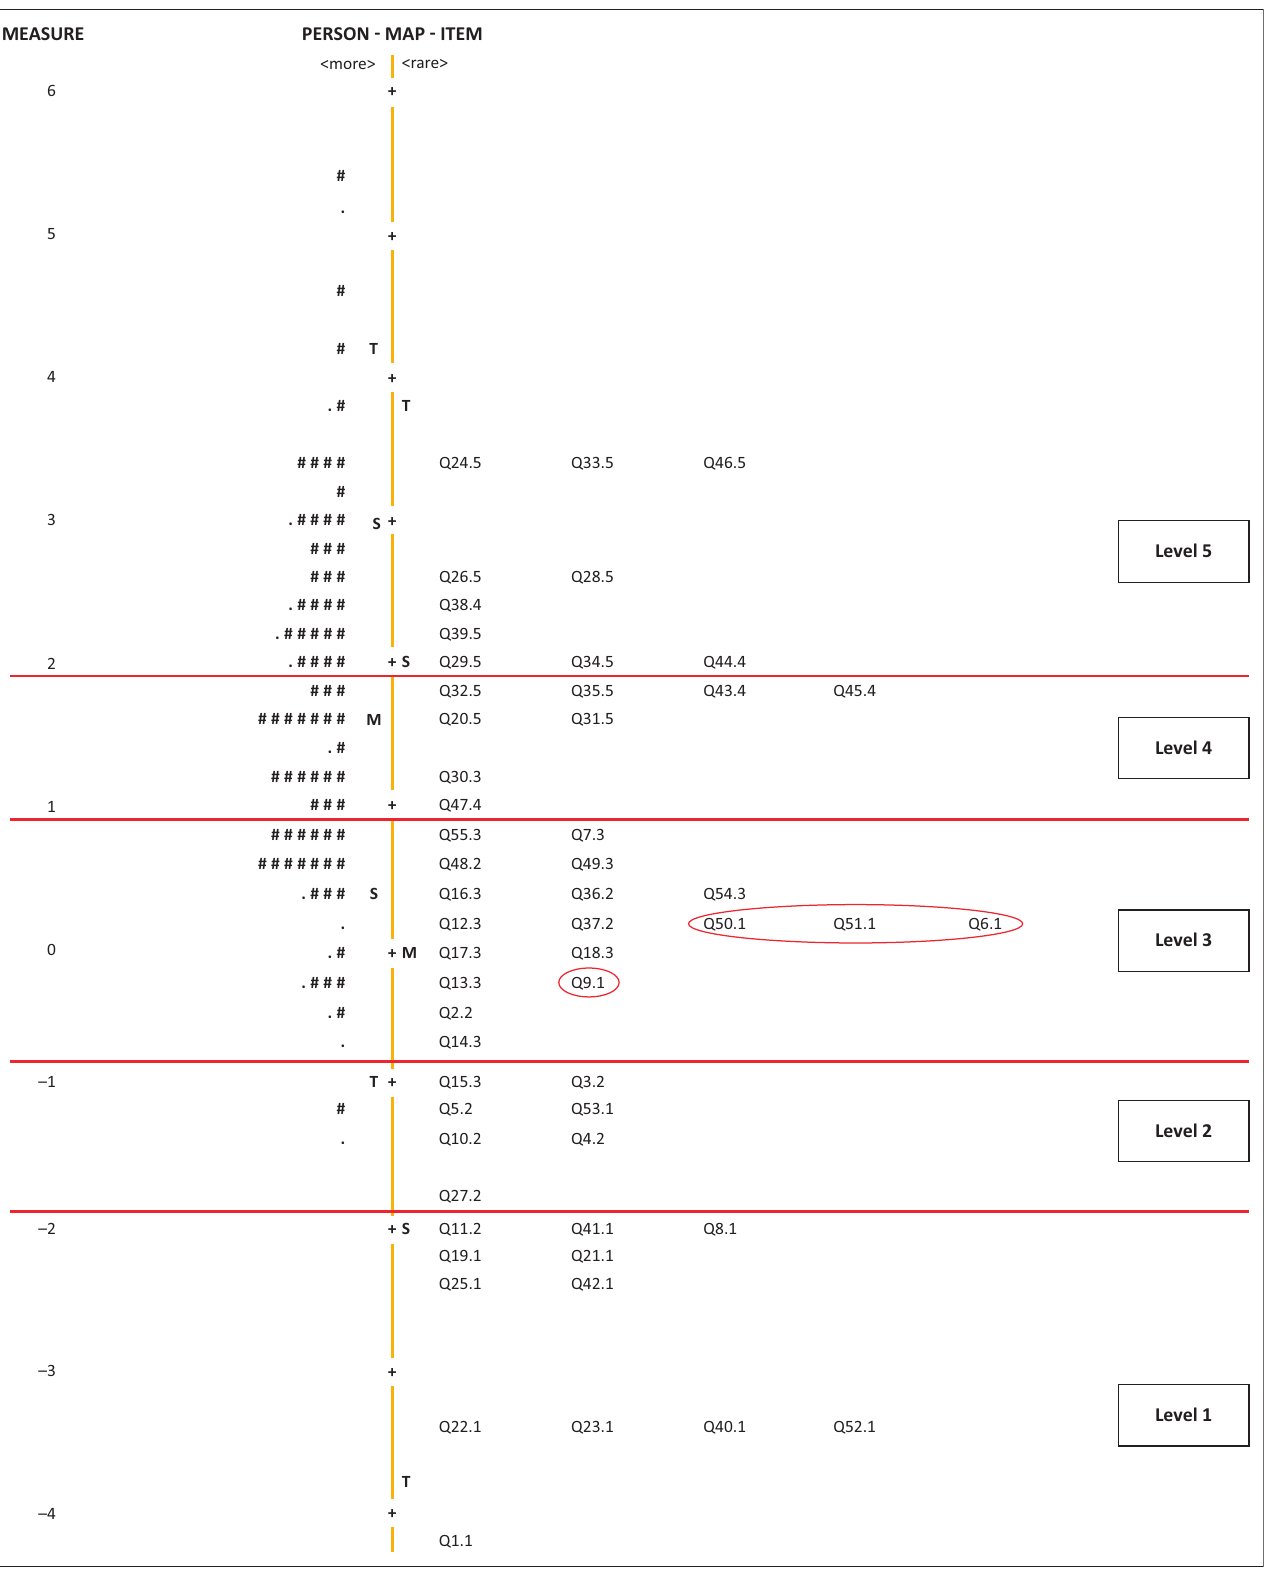
FIGURE 2: Afrikaans Mathematical and Arithmetic Competence Diagnostic’s spread of children and items on a Wright Table 1 indicates that the person reliability is 0.88 and the item reliability is 0.97. Standardised infit- or oufit values, or mean square values (MNSQ) close to 1, indicate a good model fit.